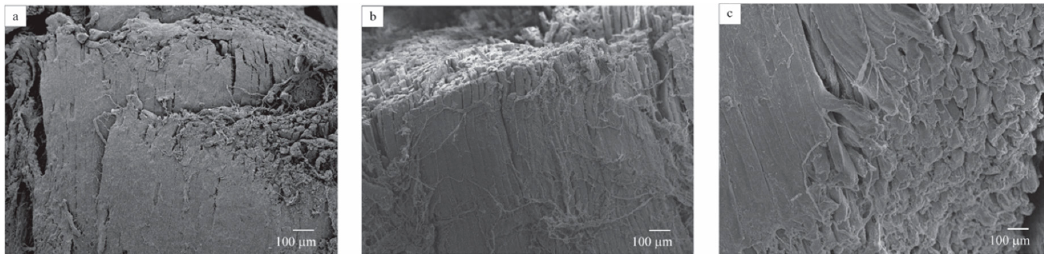
Figure 4. Scanning electron microscopy (SEM) micrographs of ( a ) fresh meat from cull cows; ( b ) vacuum-impregnated meat at p 1 of 20.3 kPa, t 1 of 0.5 h, and t 2 of 0.5 h, and ( c ) vacuum-impregnated meat at p 1 of 71.1 kPa, t 1 of 4.0 h, and t 2 of 4.0 h at 80 ×